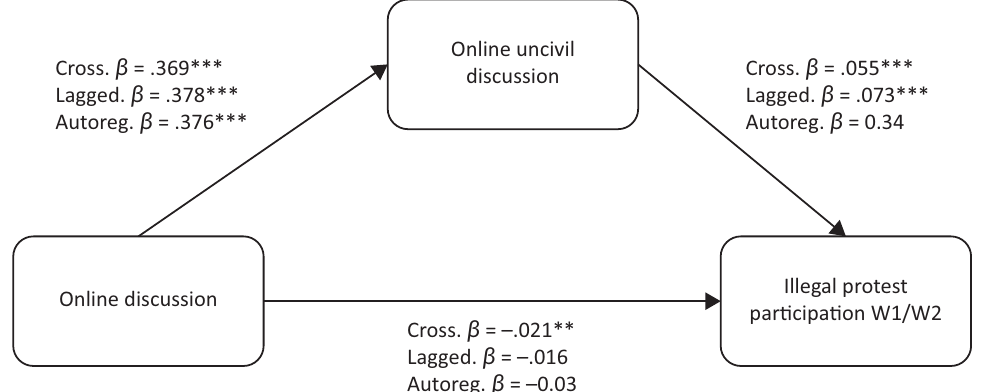
Figure 1. Cross‐sectional, lagged, and autoregressive effects of online political discussion on illegal protest, mediated through online uncivil discussion. Notes: Sample size = 1,337 (W1), 511 (W2); path entries are standardized Beta coef‐ ficients; the variables in Table 2 were included as control variables in the model; bootstrap samples for CI—5,000 simula‐ tions; the model includes the same controls and predictors as the models in Table 2; the point estimates of the indirect effects are Cross‐sectional— 𝛽 = .020, p < .001, 95% CI = [.012, .029]; Lagged— 𝛽 = .028, p < .001, 95% CI = [.009,